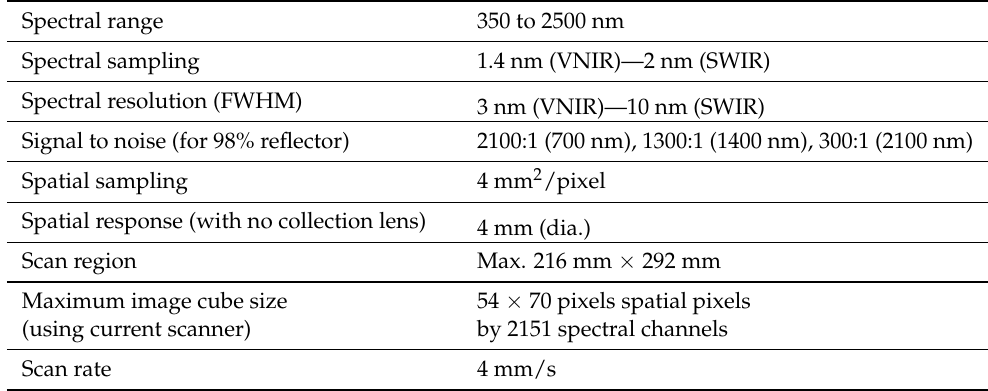
Table 1. SRS hyperspectral system technical